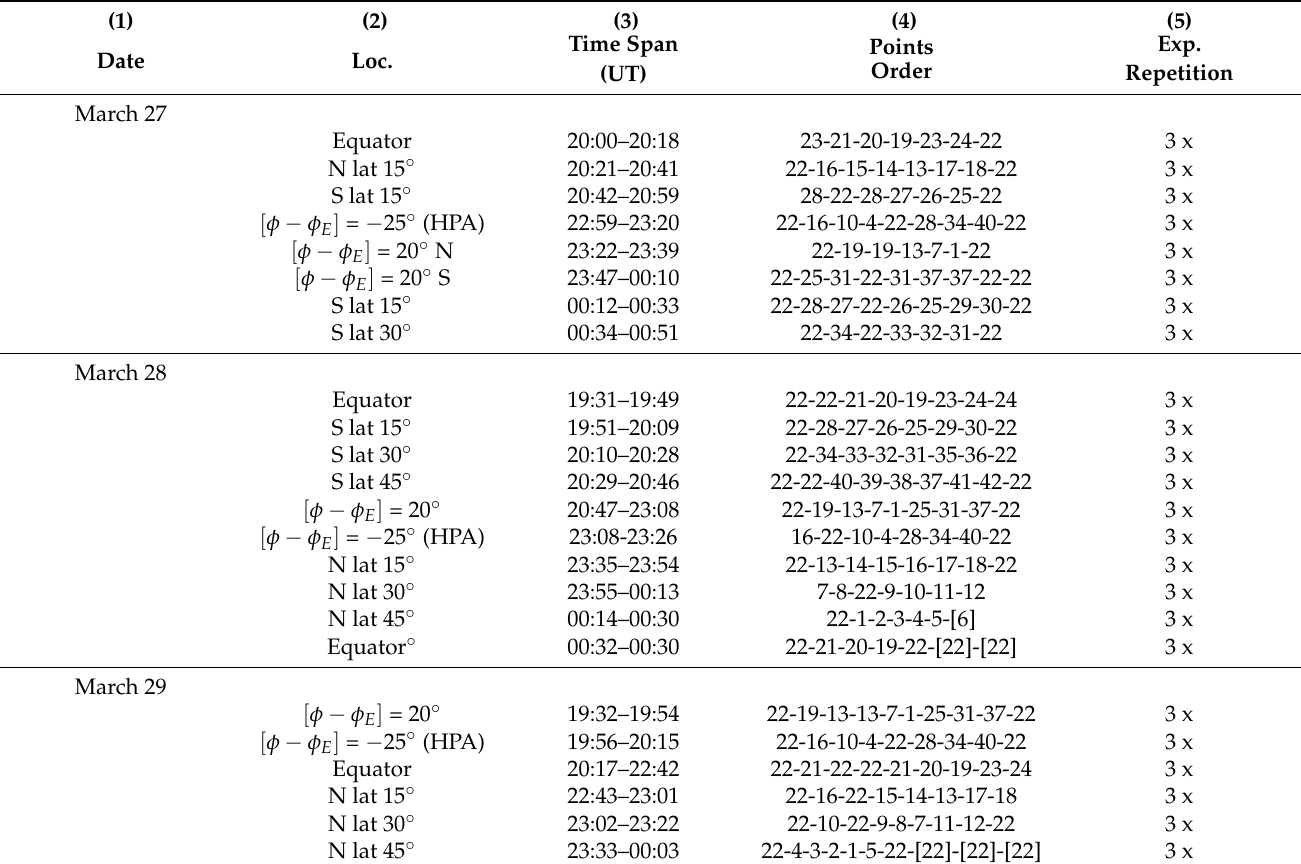
Table 2. Scanning sequences on Venus’s dayside hemisphere using CFHT/ESPaDOnS during the 27–29 March 2015 observing run: (1) date; (2) location on disk; (3) UT time interval; (4) points acquisition order; points in parentheses have been observed but not included in the kinematic best fits either for their lower S/N and/or limb or high SZA geometry; (5) exposure repetition: each point was acquired 3 times to check for internal consistency. Points in brackets were discarded from analysis due to poor visibility, severe pointing drift or tracking